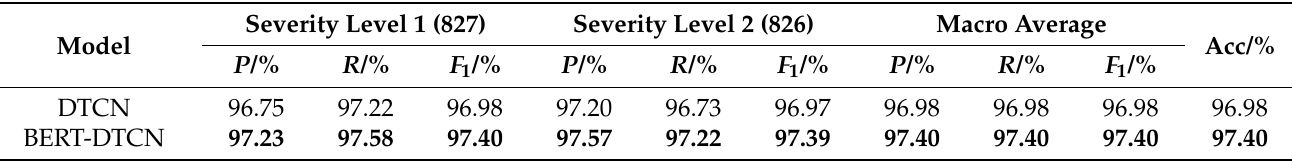
Table 5. Comparative results between BERT-DTCN with DTCN.